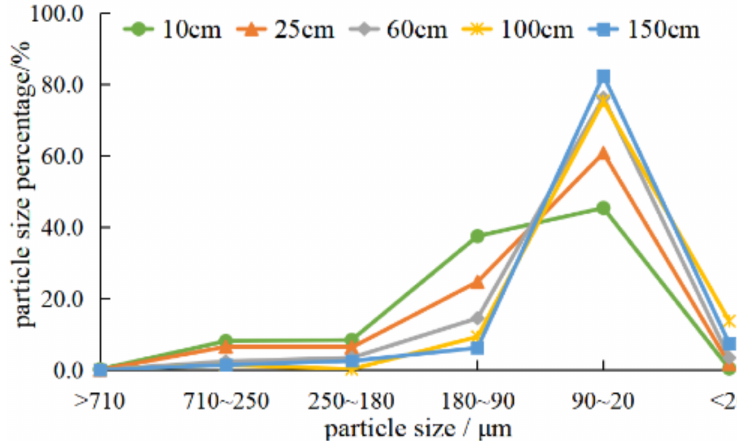
Figure 12. Miyun traditional